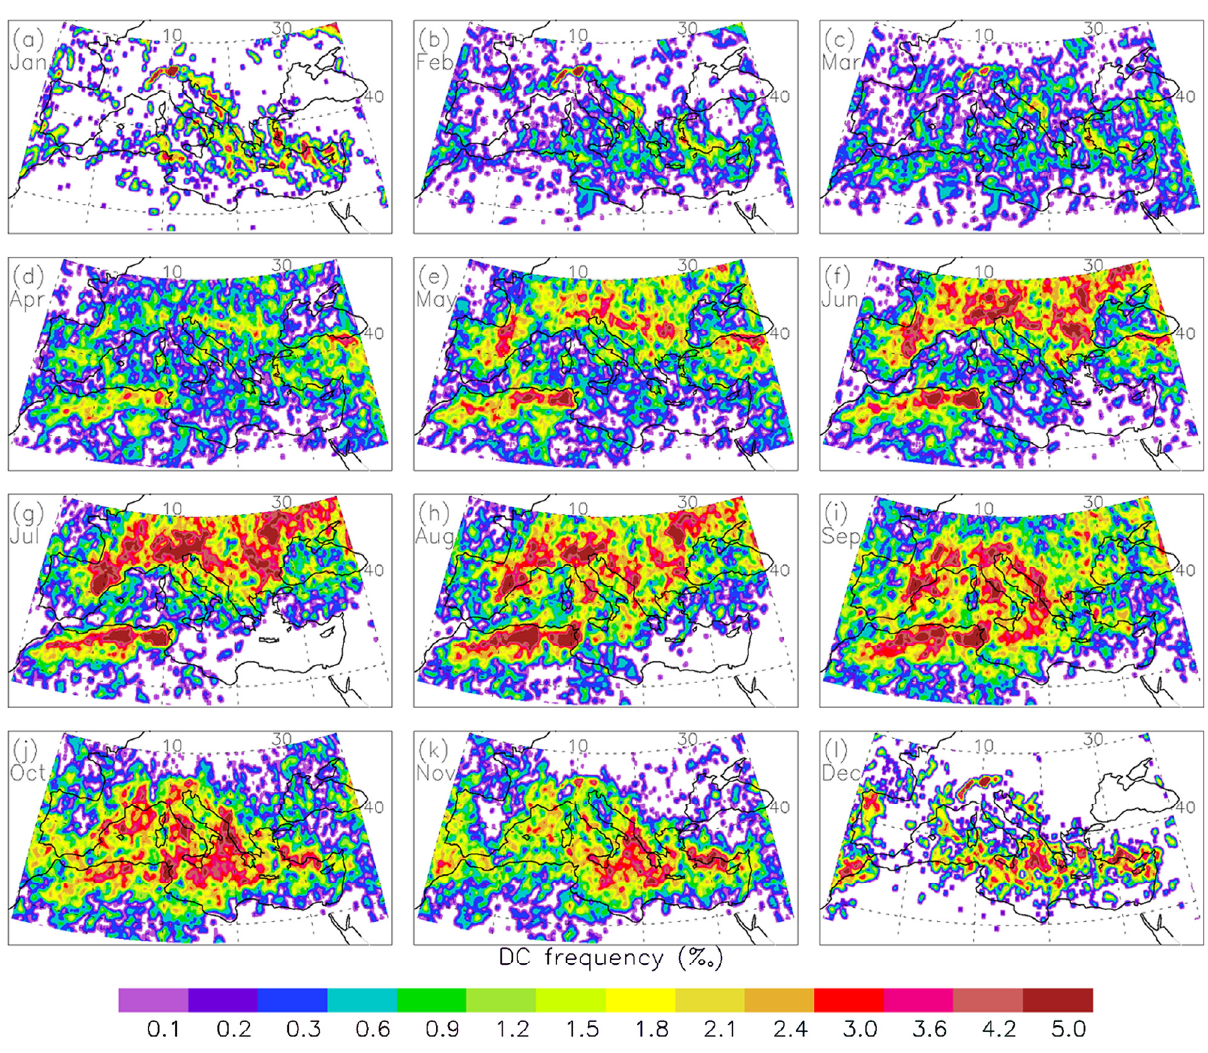
Figure 6. Spatial distribution of monthly climatology of DC frequency over the Mediterranean region from January 2000 through December 2007 from NOAA-15